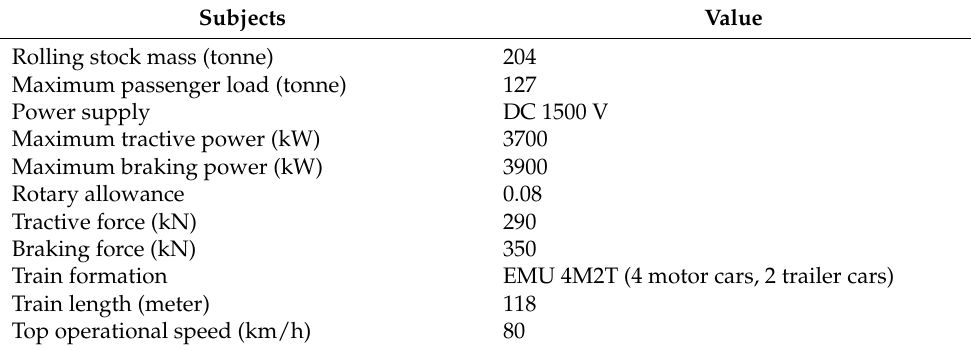
Table 4. Train characteristics.